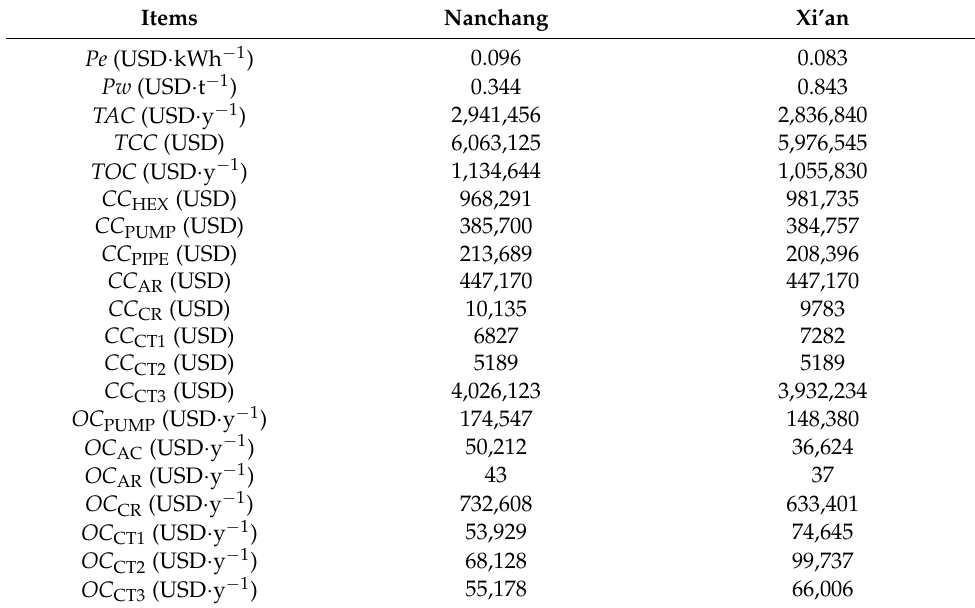
Table 7. Comparison of cascade cooling system results in different